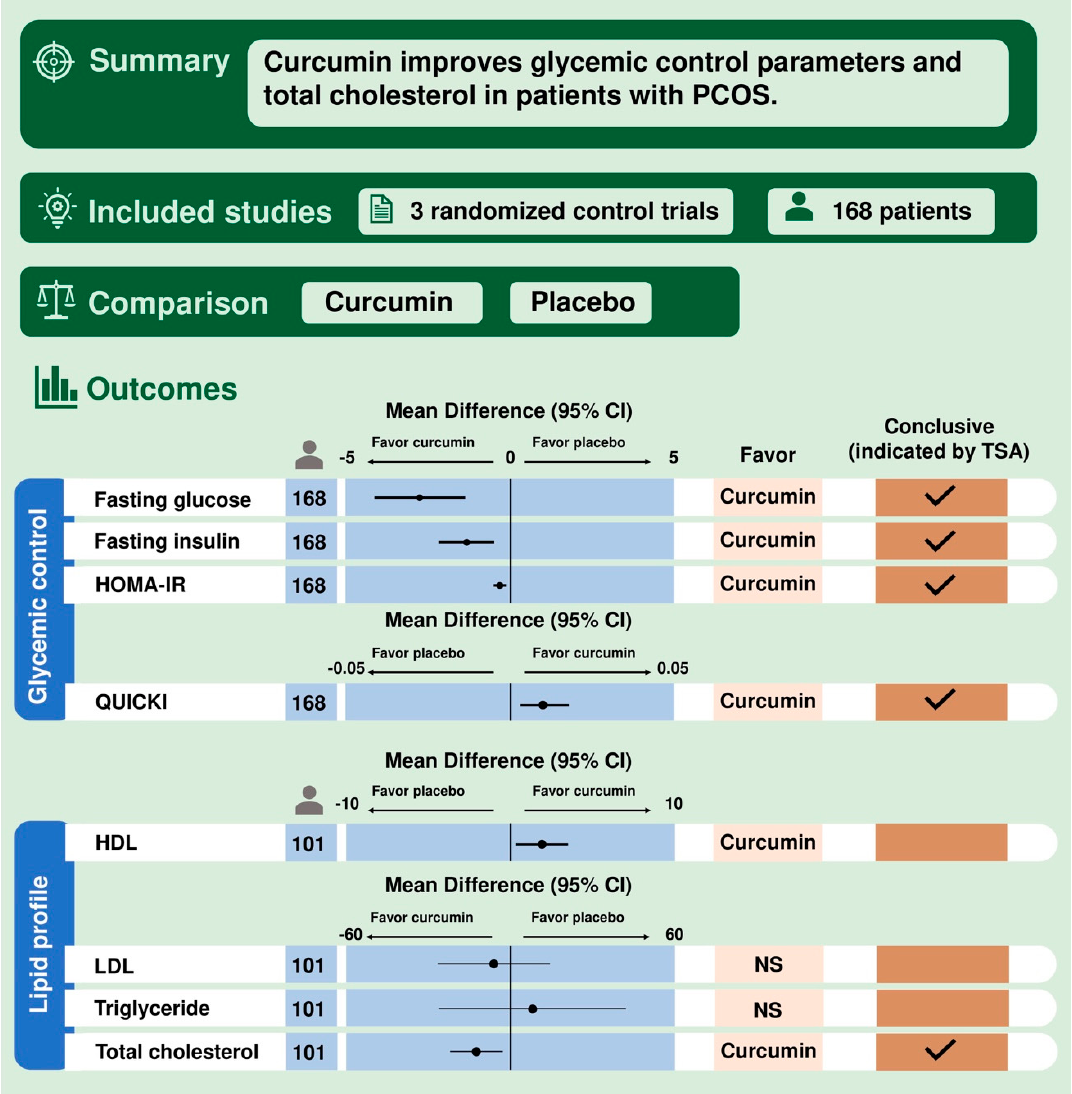
Figure 4. Visual summary abstract. CI: confidence interval. HDL: high-density lipoprotein. HOMA-IR: Homeostasis Model Assessment of Insulin Resistance. LDL: low-density lipoprotein. NS: non-significant. PCOS: polycystic ovary syndrome. QUICKI: quantitative insulin sensitivity check index. TSA: trial sequential analysis.